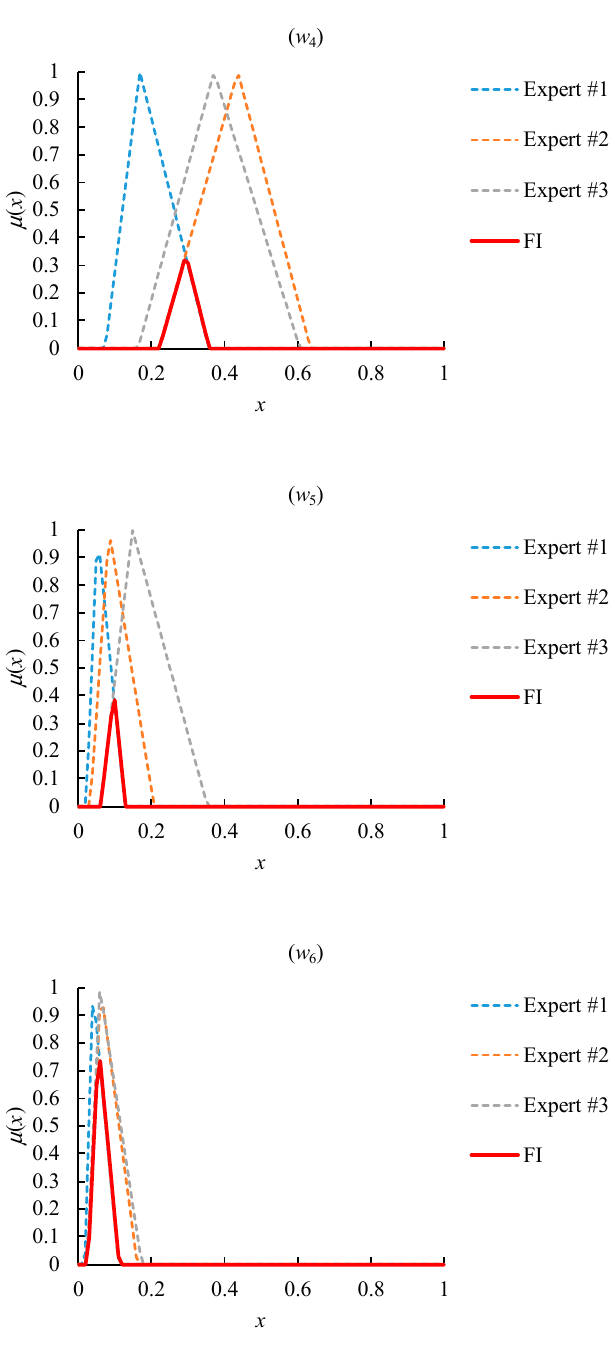
Figure 10. The FI result of the relative priorities evaluated by experts.